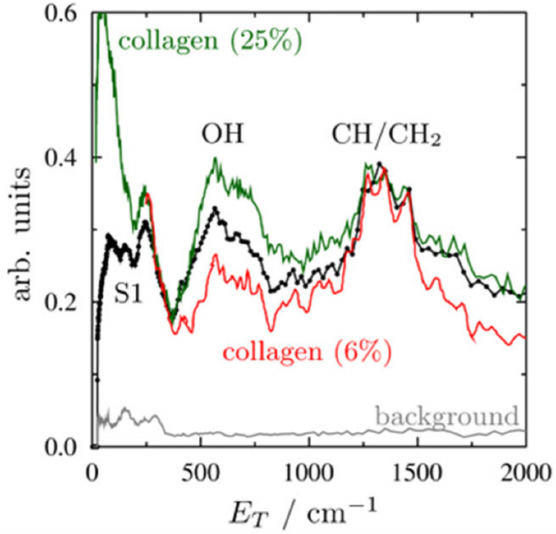
Figure 4. INS spectra of S1 and the experimental background from this work, compared to two reference spectra for collagen at hydration levels of 25% and 6% from Ref.